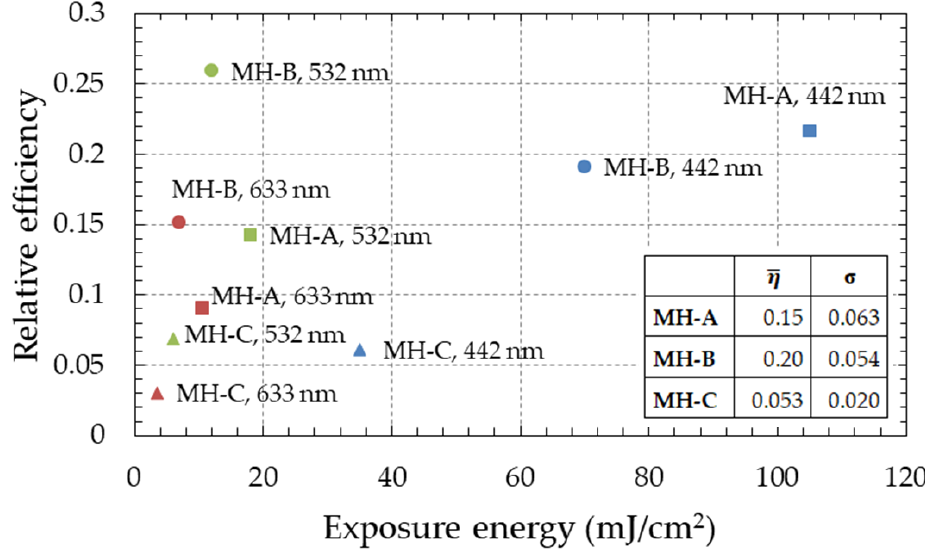
Figure 9. Efficiency as a function of exposure in polychromatic calibration for three multiplexed holograms. Each marker corresponds to a multiplexed hologram and each color of the same marker corresponds to the efficiency obtained for each of the three holograms that compose one multiplexed hologram.